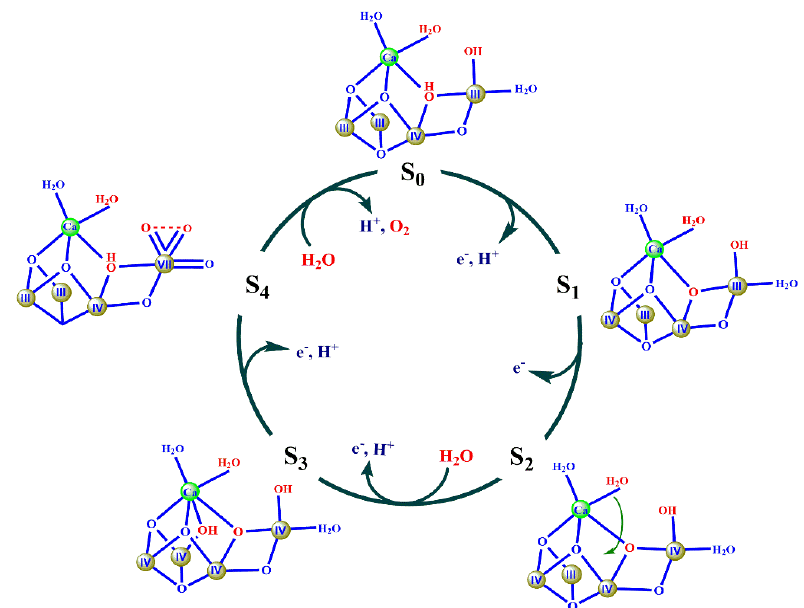
Figure 6. The hypothesis for the O-O bond formation involving a Mn VII species [88]. All other depictions are the same as that in Figure 3. For clarity, all protein ligands of OEC are omitted. During the S 3 → S 4 state transition, two protons of two hydroxide groups bound to the dangling manganese ion are delivered to D 1 -Asp 170 and D 1 -Glu 333 , respectively [88].